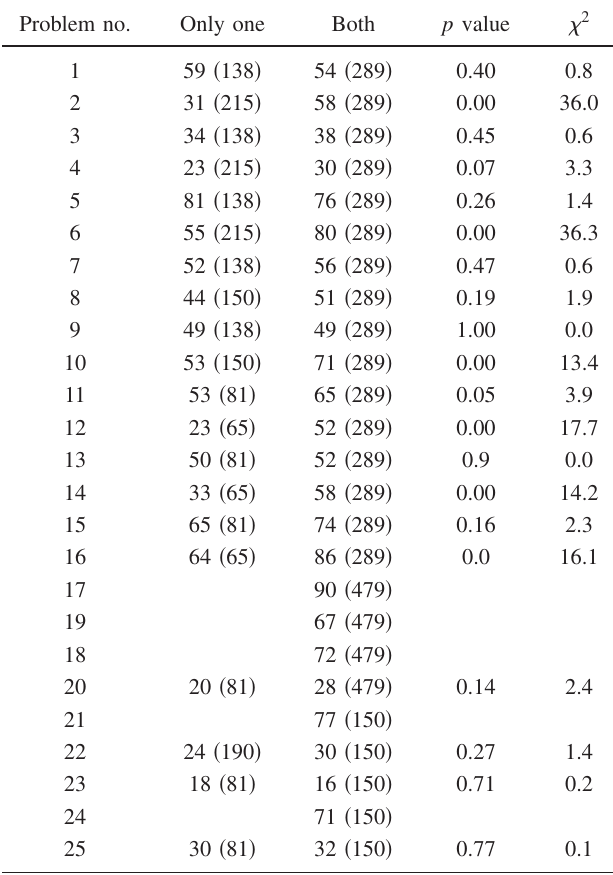
TABLE I. Summary of results. For the isomorphic problems given in the multiple-choice format (cid:1) see the Appendix (cid:2) , the first column lists the problem numbers, the second column gives the percentage of students who chose the correct answer when only one of the questions was given to them, and the third column gives the percentage of students who chose the correct answer when both questions (cid:1) triplet for questions 21–23 (cid:2) were given. The numbers in parentheses in the second and third columns refer to the number of students who answered the question. The last two columns for all questions list the p value and (cid:2) 2 for comparison of student perfor- mance between cases when only one of the isormorphic questions was given vs when the question was given with its isomorphic